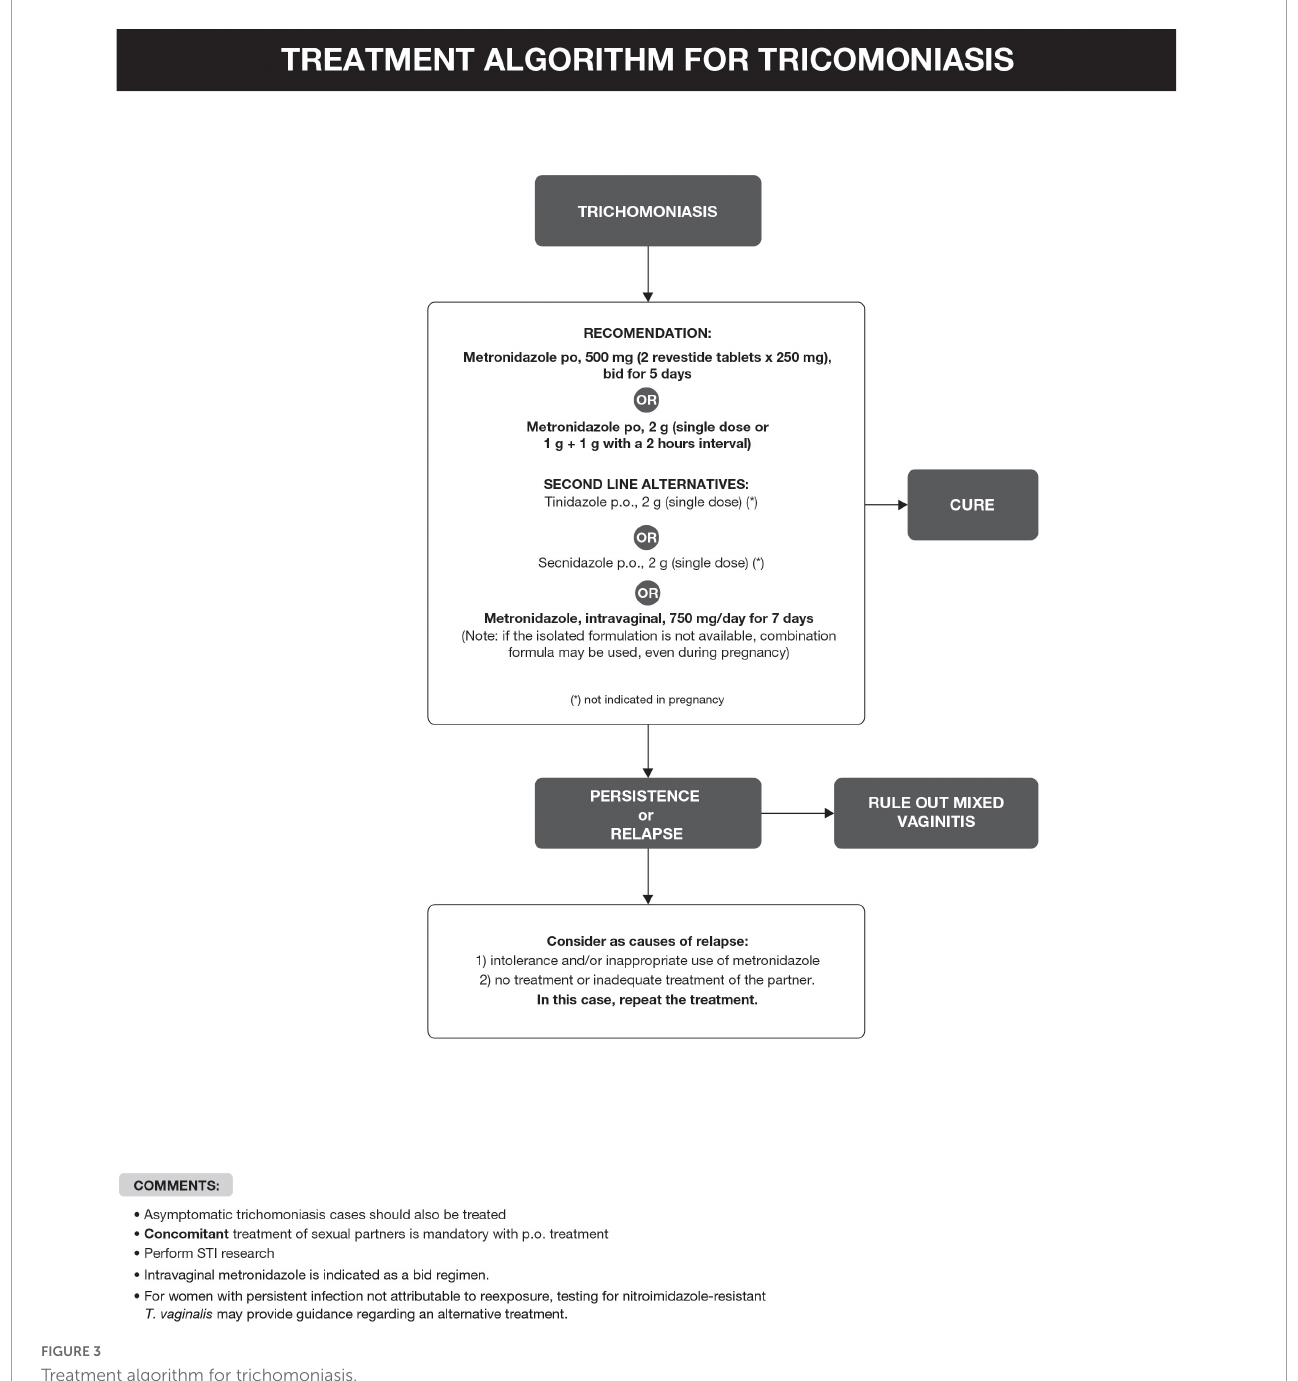
FIGURE3 Treatment algorithm for